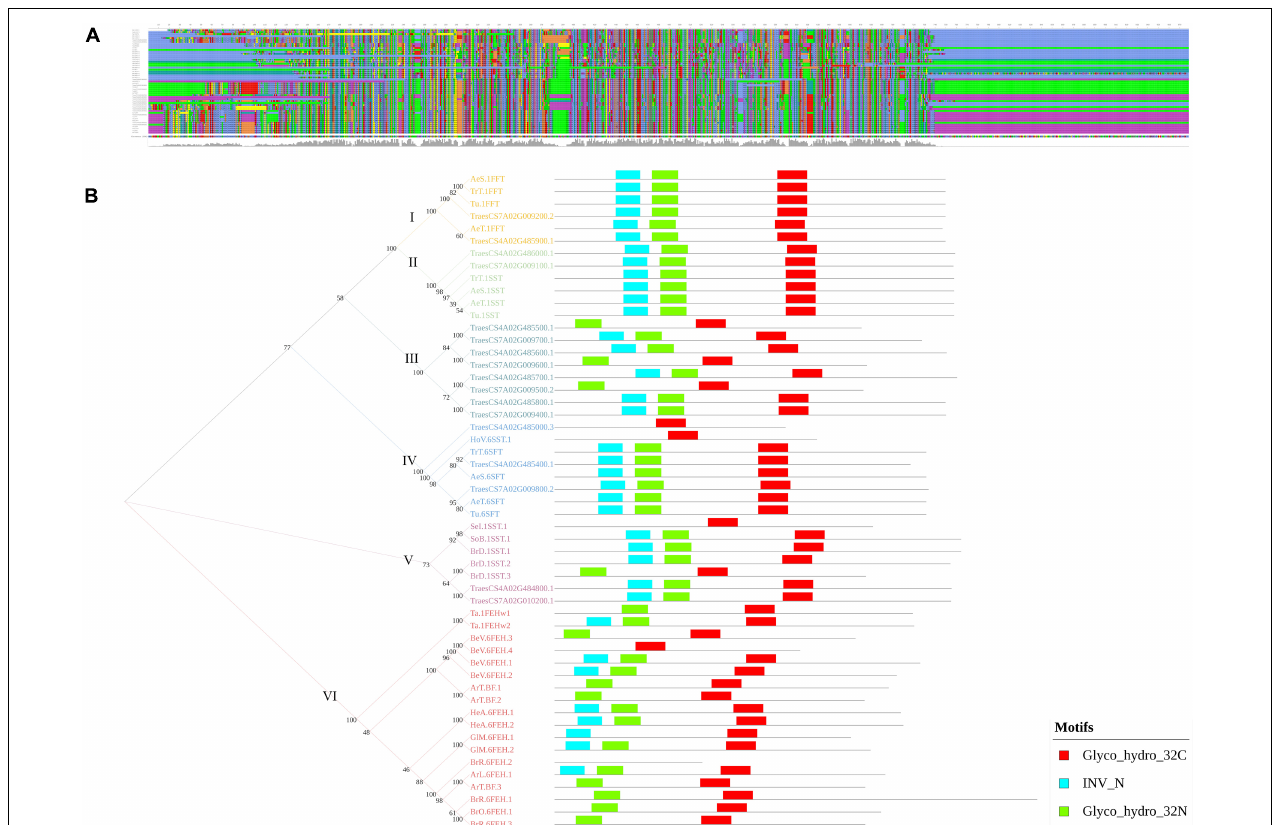
FIGURE 7 | The multiple sequence alignment (A) and phylogram with a comparison between motif structures of the fructans metabolic genes of Triticum aestivum and model plant species (B) . In (B) , the Arabic numbers indicate the bootstrap values, whereas the Roman numbers indicate the cluster number.